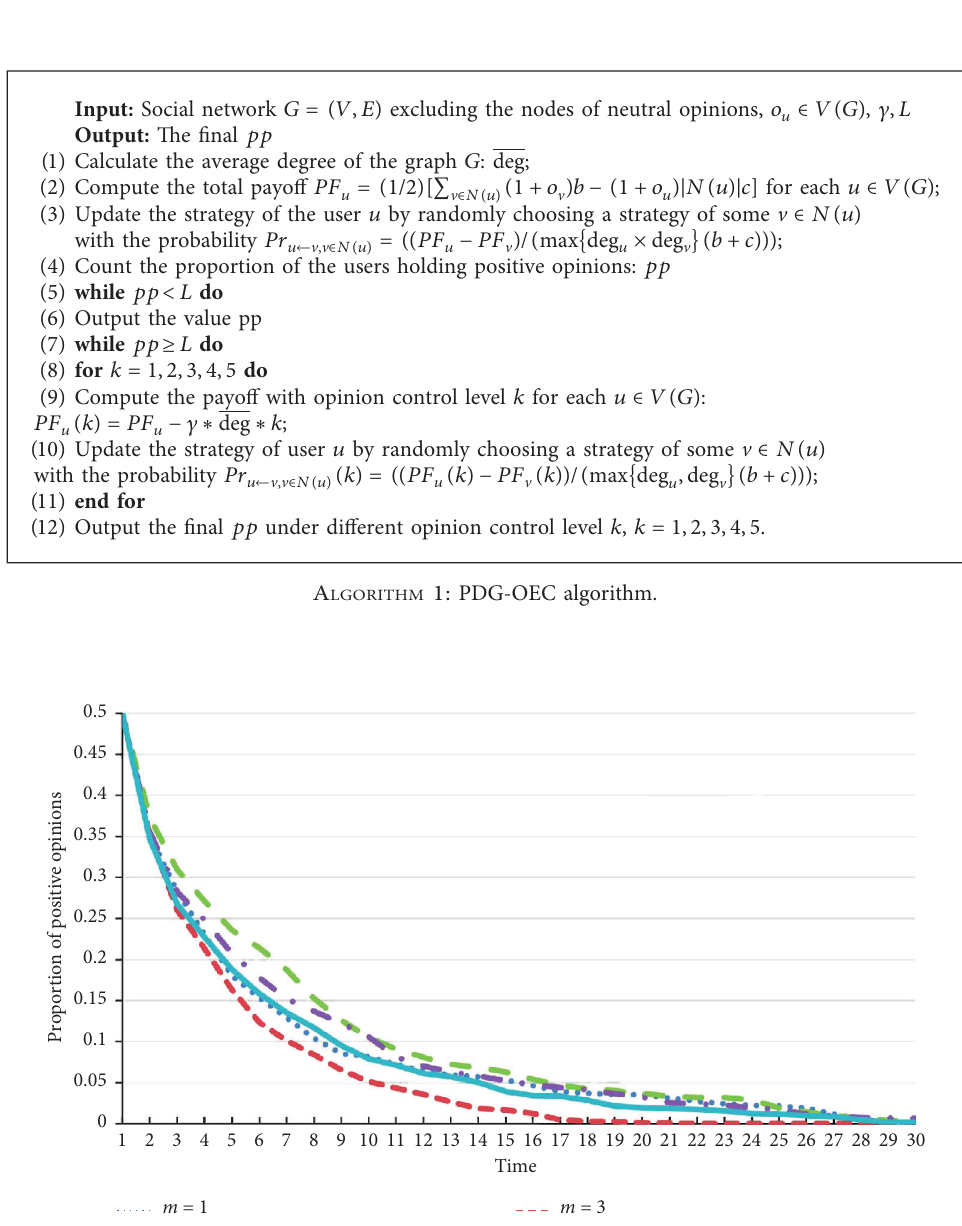
� 20 and m � 1 , 3 , 5 , 7 , 0